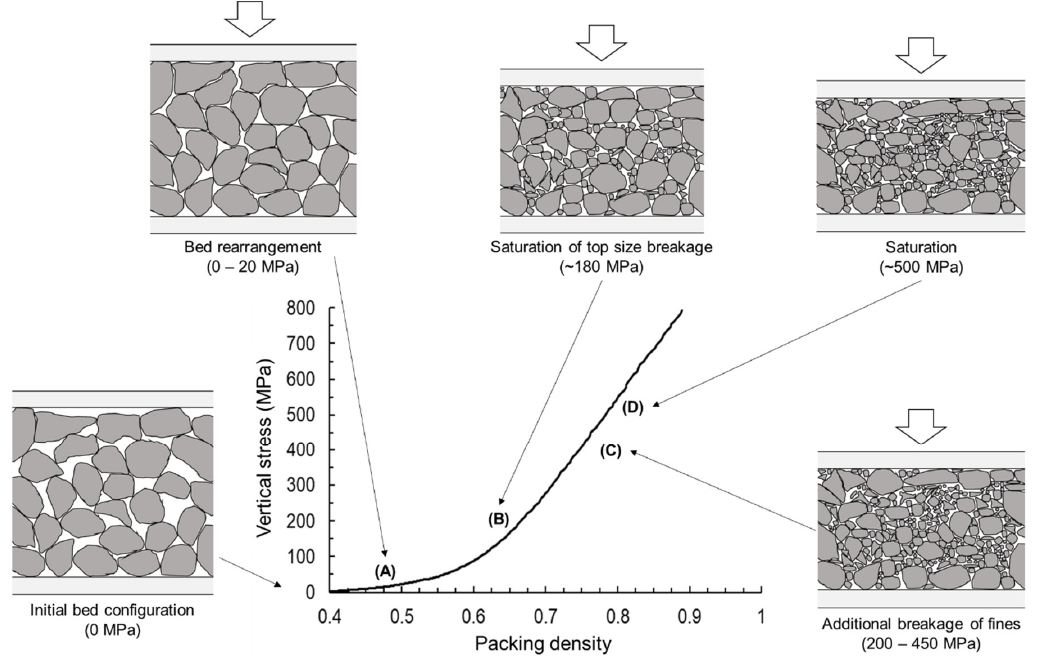
Figure 13. Schematic summarizing the main features of the particle bed pressing behavior of fine iron ore particles.